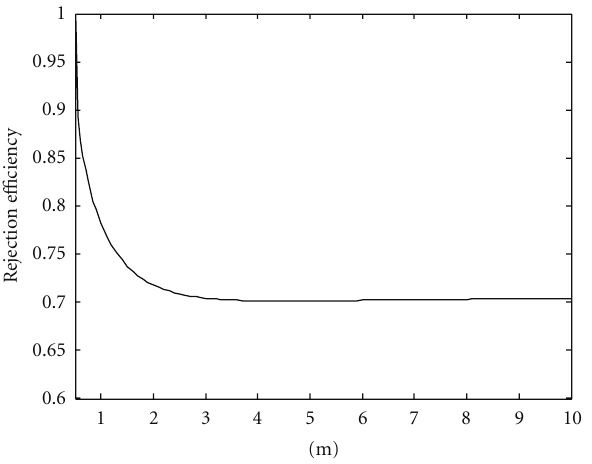
Figure 2: Rejection e ffi ciency of the new method.